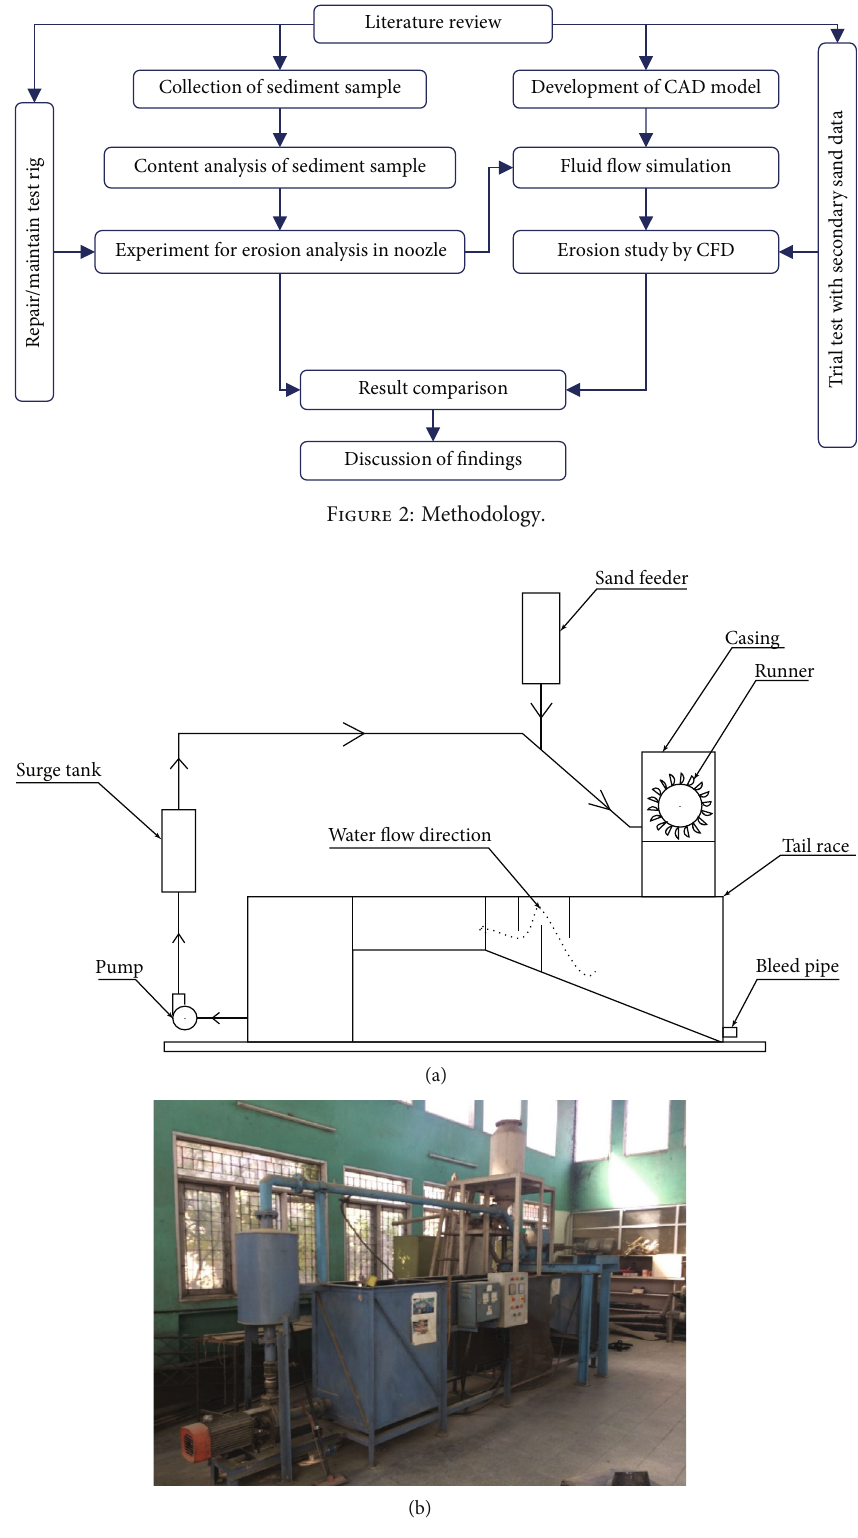
Figure 3: (a) Schematic of the test rig and (b) the test rig used in the study previously used by Bajracharya [17].